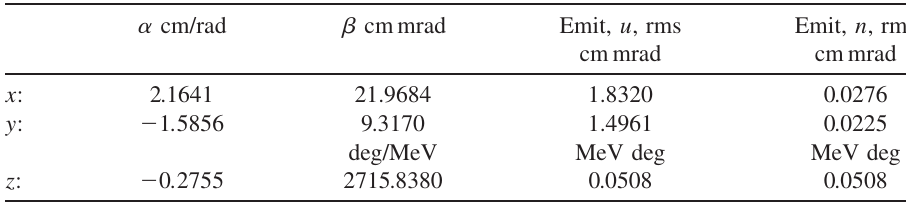
TABLE V. Ellipse parameters at the end of the 33rd cell.